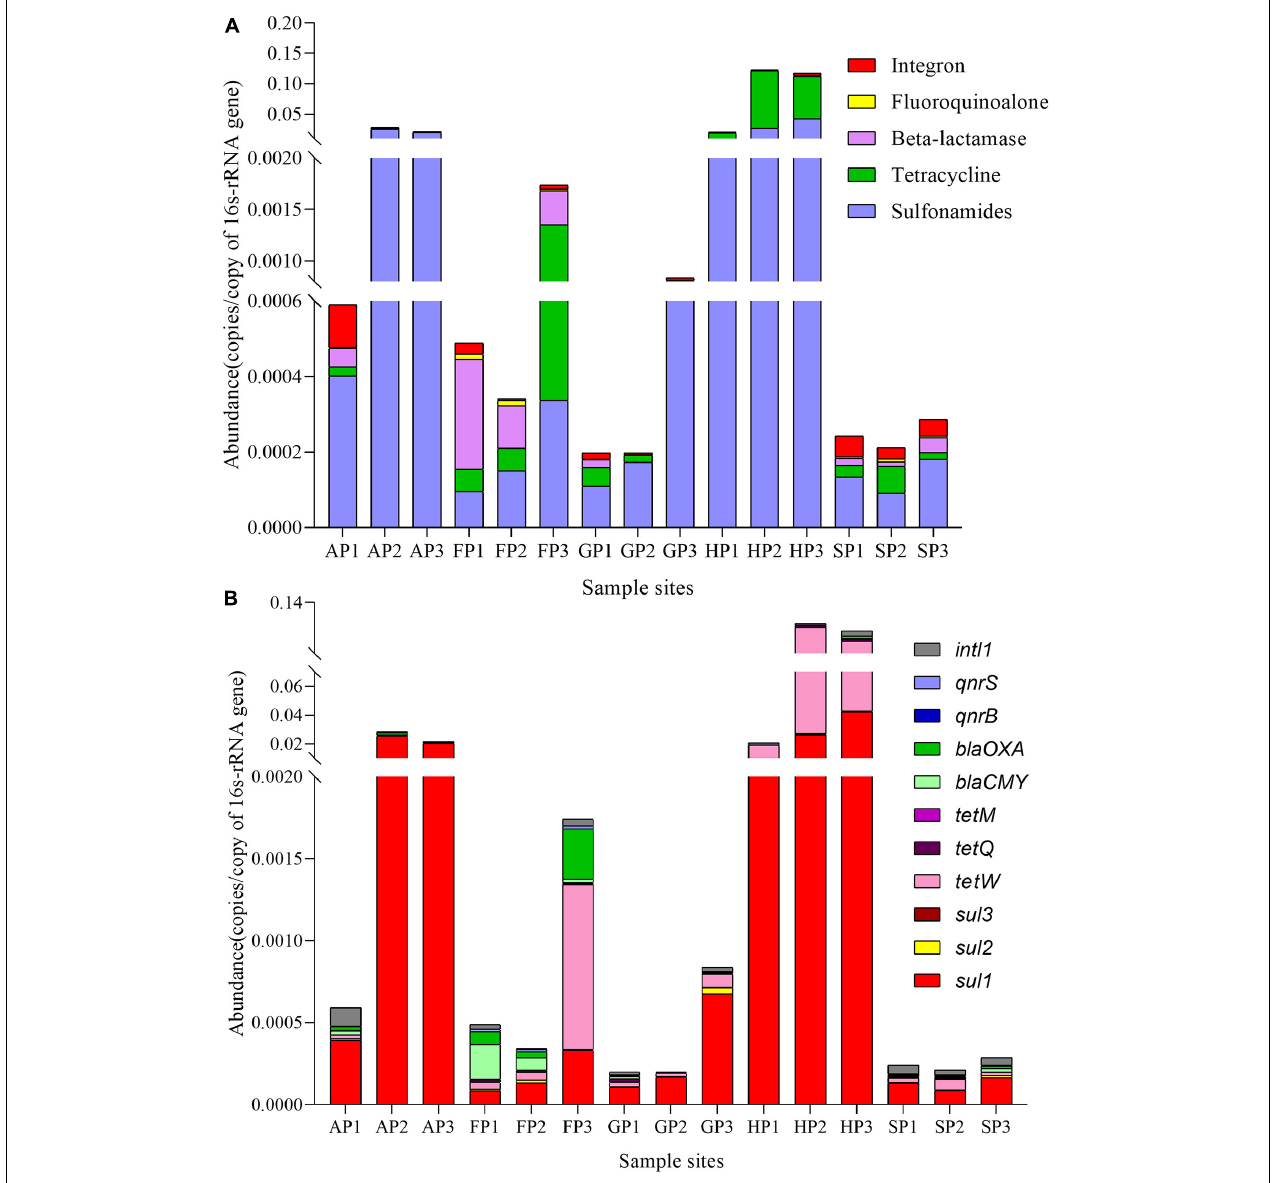
FIGURE 3 | The abundance of antibiotic resistance genes (ARGs) in the 15 sediment samples. (A) Five categories. (B) 11 kinds.